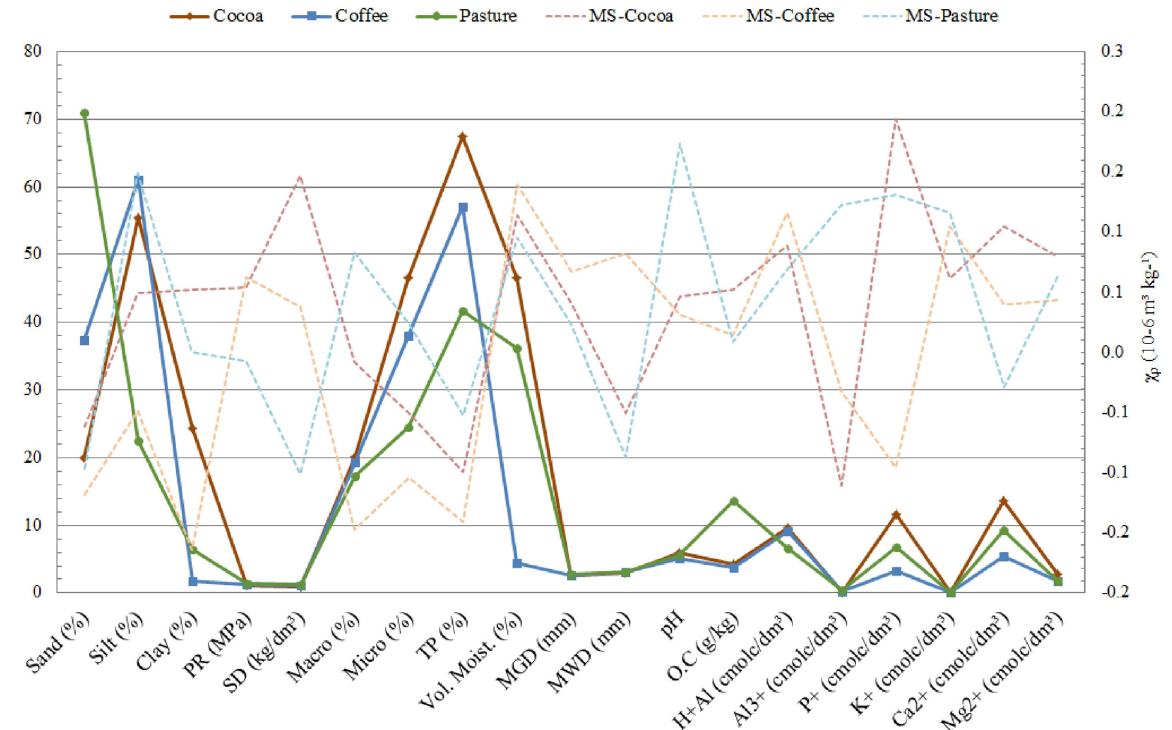
Figure 2. Correlation intensity of DM with physical attributes in soil chemists in IBEs under